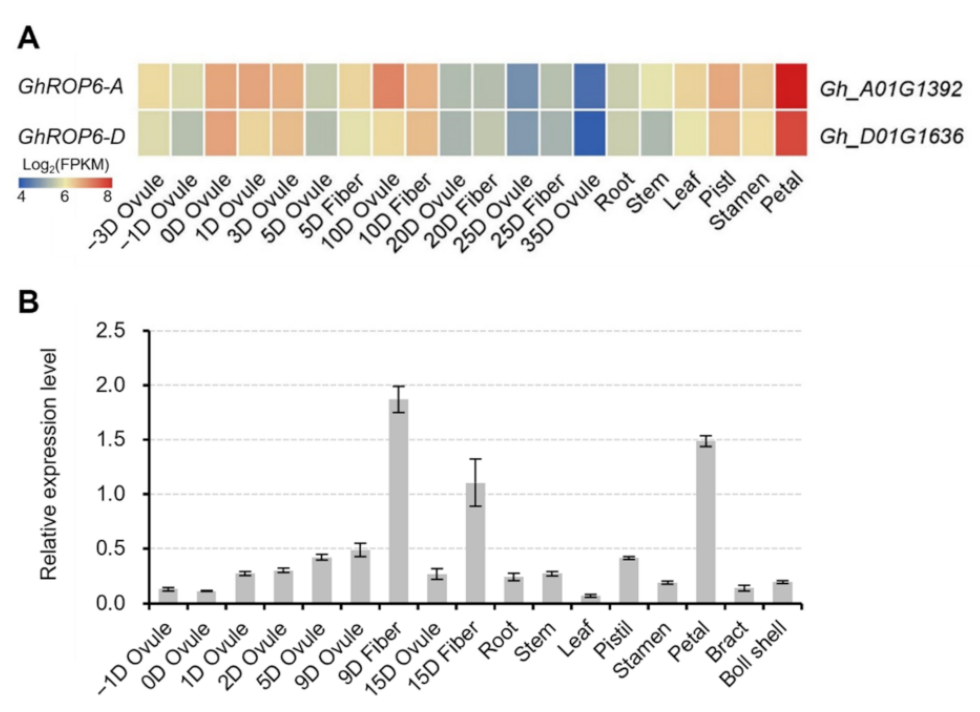
Figure 1. Expression profile of GhROP6 in cotton tissues. ( A ) Heatmap of expression pattern of GhROP6 copies. GhROP6-A (Gh_A01G1392) and GhROP6-D (Gh_D01G1636) are two copies of GhROP6 in A- and D-subgenome of upland cotton. The heatmap was generated from the released data [21]. (B ) Transcription level of GhROP6 (in arbitrary units) normalized to that of GhHIS3 . Error bars represent standard deviation of three technical repeats. Samples at − 3 to 3 DPA ( A ) or − 1 to 5 DPA ( B ) were fiber-bearing